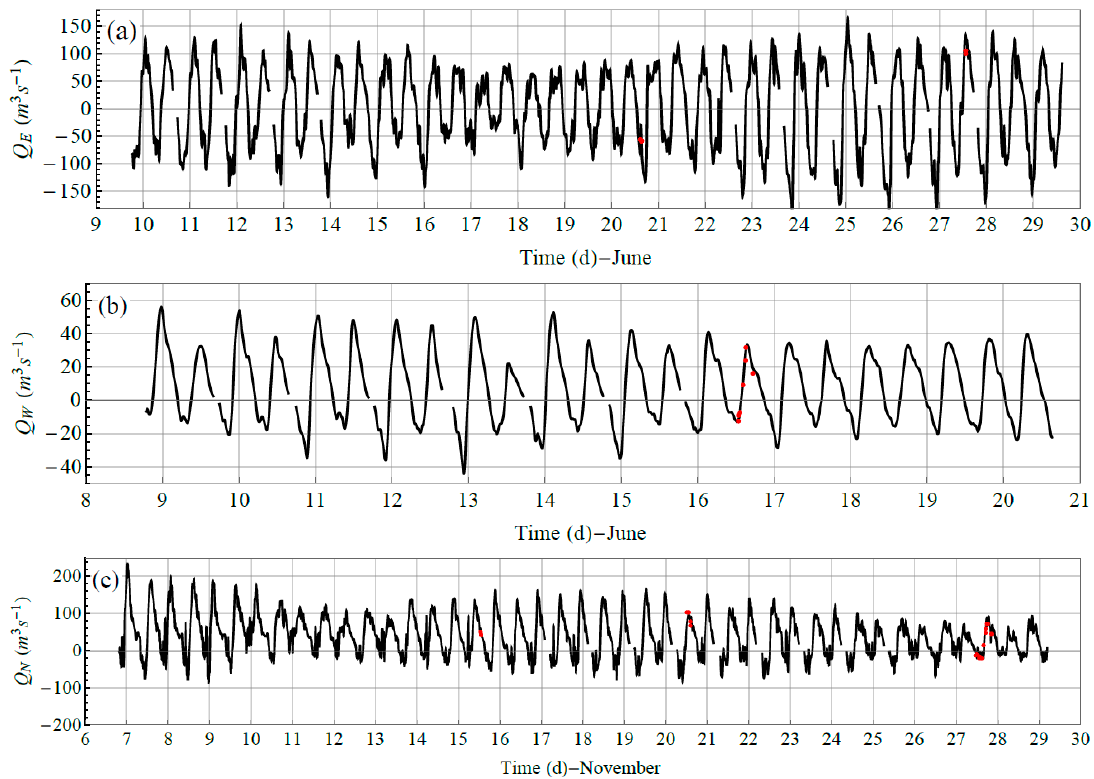
Figure 4. Temporal variations of ( a ) tidal discharge at the eastern branch, ( b ) tidal discharge at the western branch, and ( c ) tidal discharge at the northern branch. The red dots denote the discharge obtained using moving-boat ADCP measurements. Discontinuations of the discharge time series correspond to the missing period, as the result of the transducers were not covered by water during low tide.